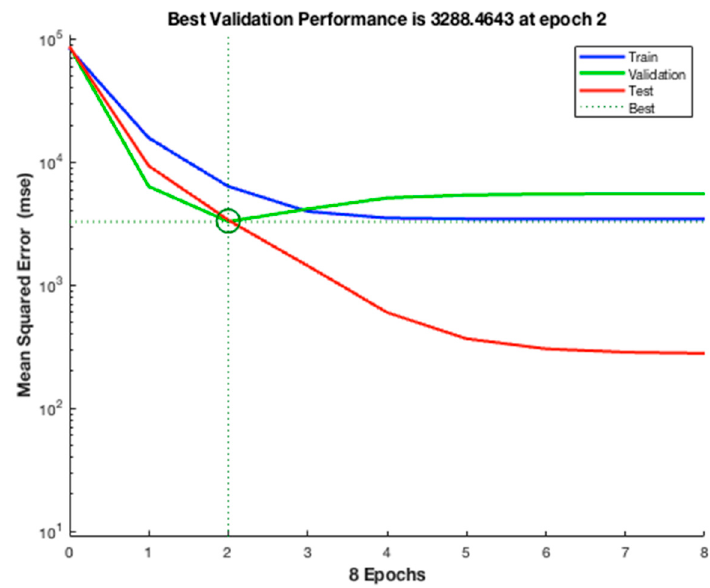
Figure 7. Mean Square Error (MSE) plot.